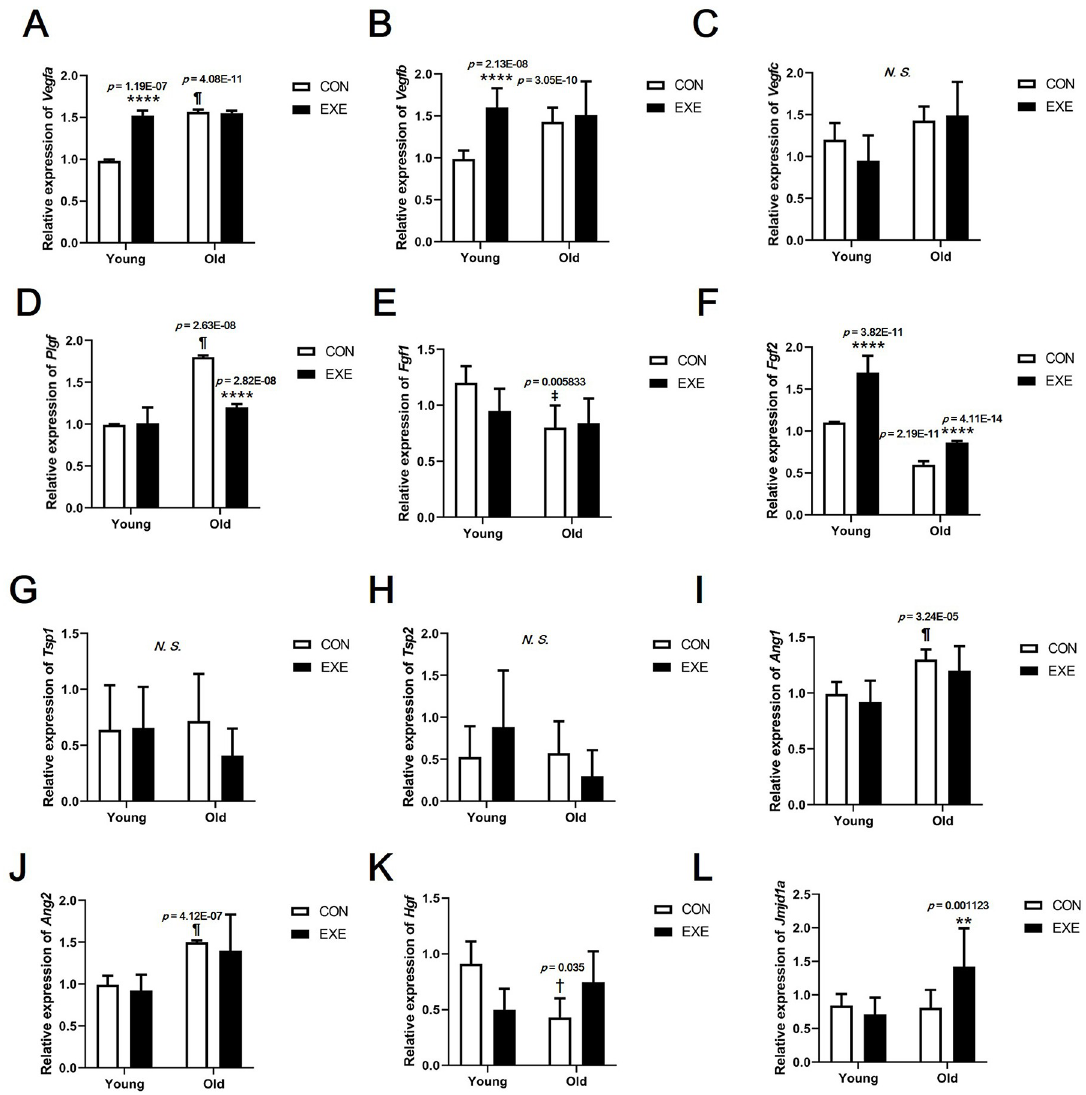
Fig 5. Expression of angiogenesis-related genes in endothelial cells (ECs) isolated from blood vessels of mice subjected to LSE. (A) Vegfa expression level. (B) Vegfb expression level. (C) Vegfc expression level. (D) Plgf expression level. (E) Fgf1 expression level. (F) Fgf2 expression level. (G) Tsp1 expression level. (H) Tsp2 expression level. (I) Ang1 expression level. (J) Ang2 expression level. (K) Hgf expression level. (L) Jmjd1a expression level. All data are presented as the mean ± SD vs. control group of same age, �� p < 0.01 and ���� p < 0.0001; vs. control group of different age, † p < 0.05, ‡ p < 0.01, and ¶ p < 0.0001. N . S . = no significant difference between groups.